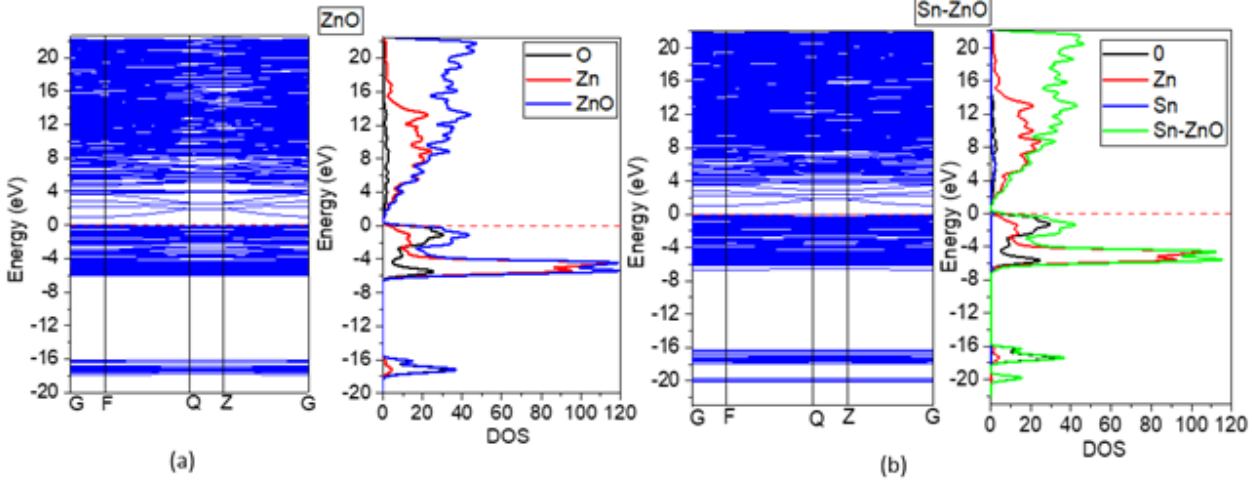
Figure 3. Band structures and DOS plots for ( a ) pure ZnO and ( b ) Sn − doped ZnO (101) surfaces.